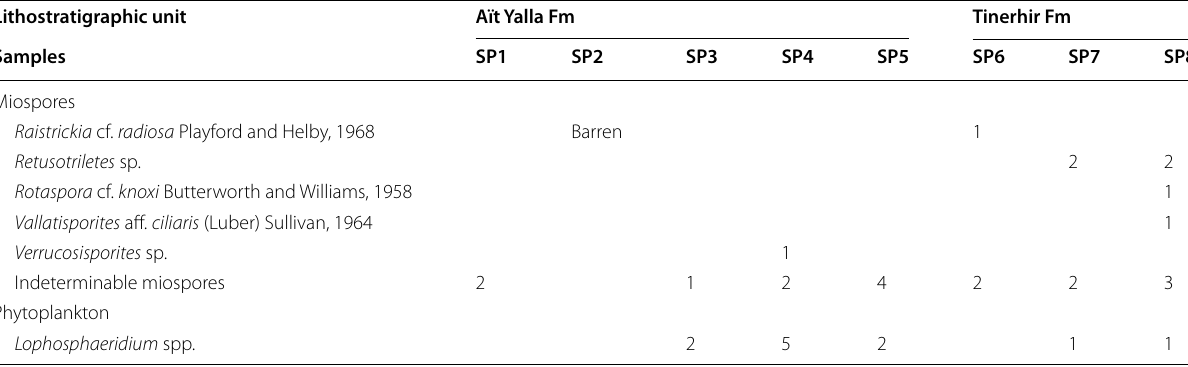
Table 1 Distribution of the palynomorph taxa in the studied samples Lithostratigraphic unit